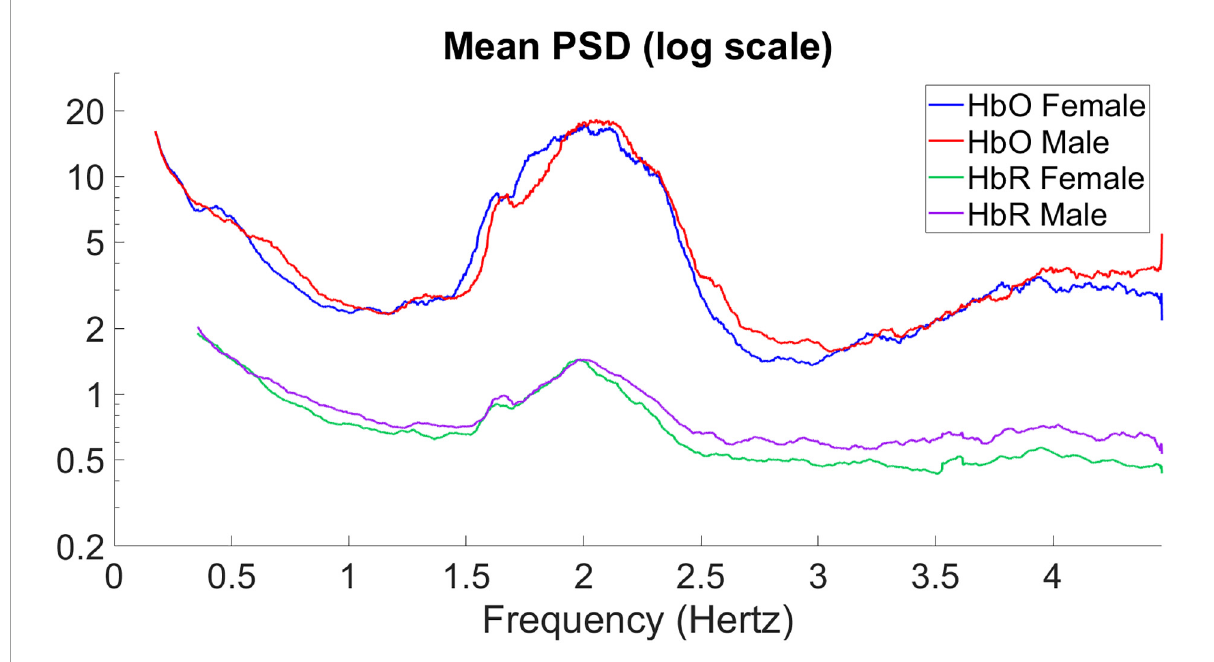
FIGURE3 Mean power spectral density of the average signal for HbO and